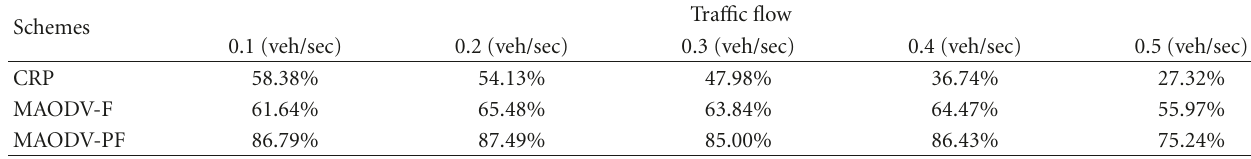
Table 3: The prediction accuracy comparison for CRP, MAODV-F, and MAODV-PF under di ff erent tra ffi c